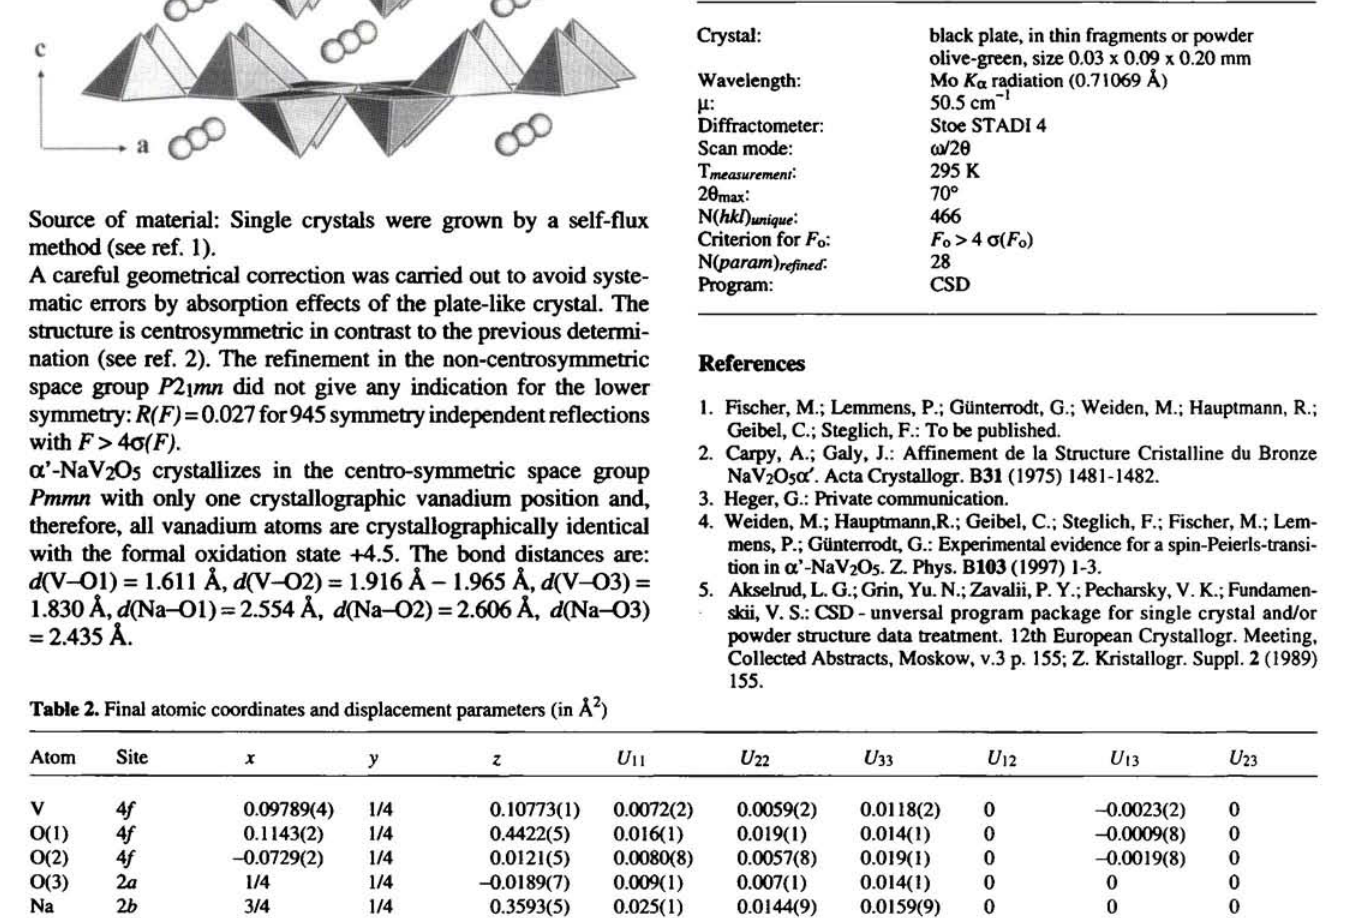
Table 1. Parameters used for the X-ray data collection